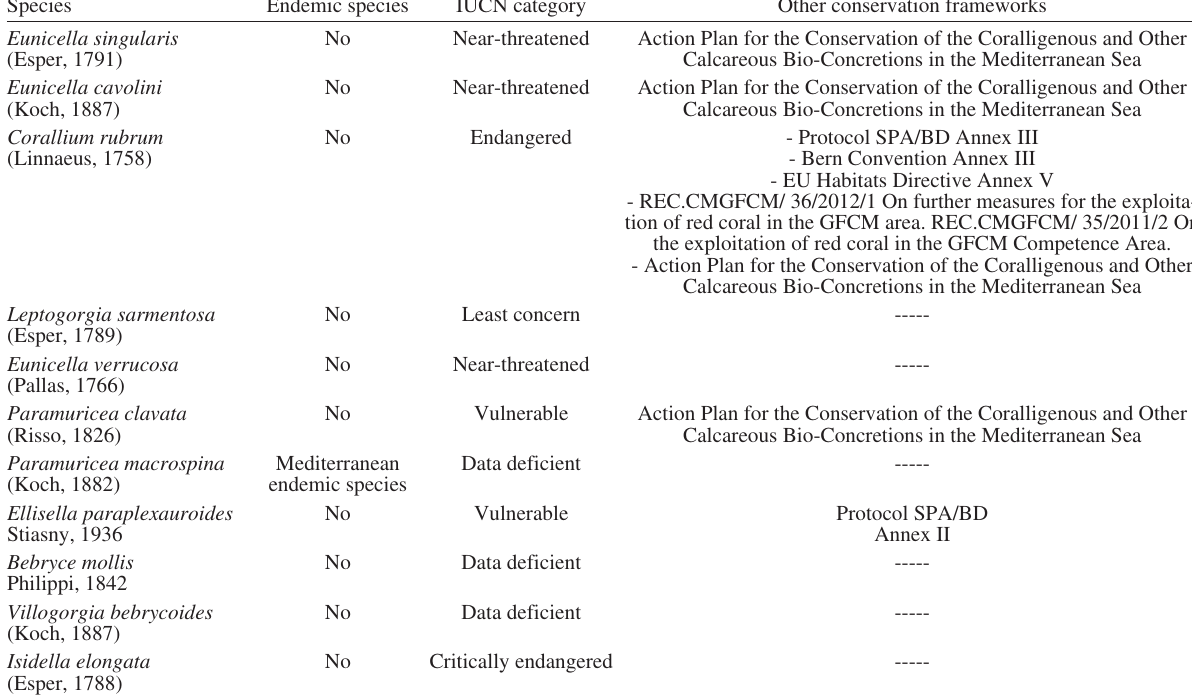
Table 4. – Conservation frameworks of Tunisian gorgonian